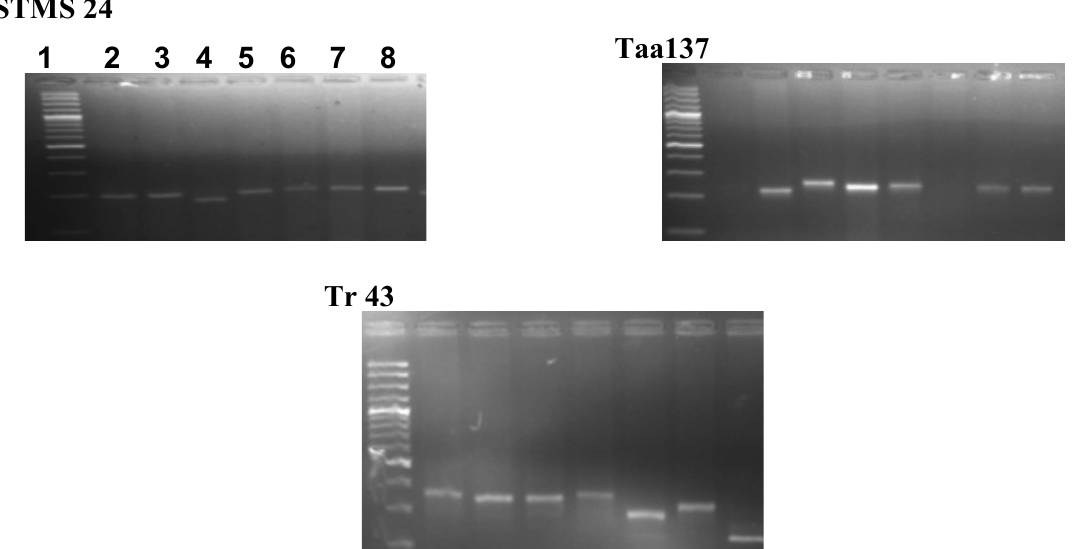
Figure 2. Parental polymorphism between BG256 and wild derivative lines. Lane 1, 100bp M; 2, C. pinnatifidum 188; 3; ICCV 96030; 4, GL 29029; 5, GL 29206; 6, GL29212; 7, GL29081; 8-BG 256.